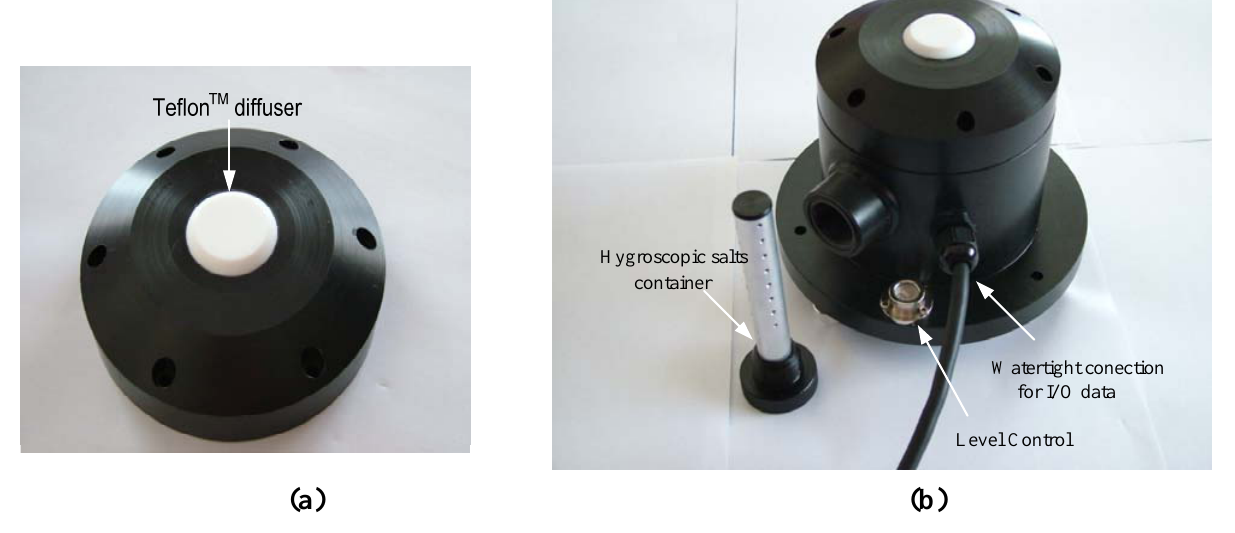
Figure 4. Developed pyranometer: (a) Detail of the diffuser in the pyranometer top. (b) Body of the pyranometer showing the container of hygroscopic salts and gauge